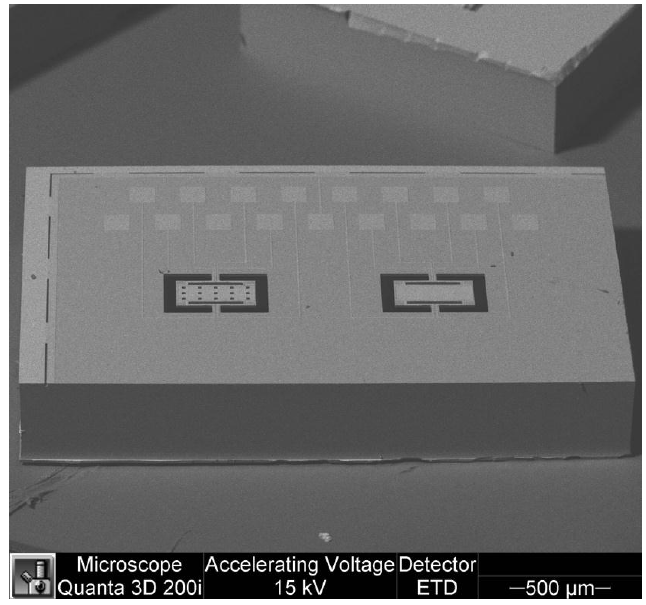
Figure 3. SEM image of two magnetic field sensors formed by silicon resonators, which are fabricated using a bulk micromachining process. (Courtesy of A. L. Herrera-May, Universidad Veracruzana).